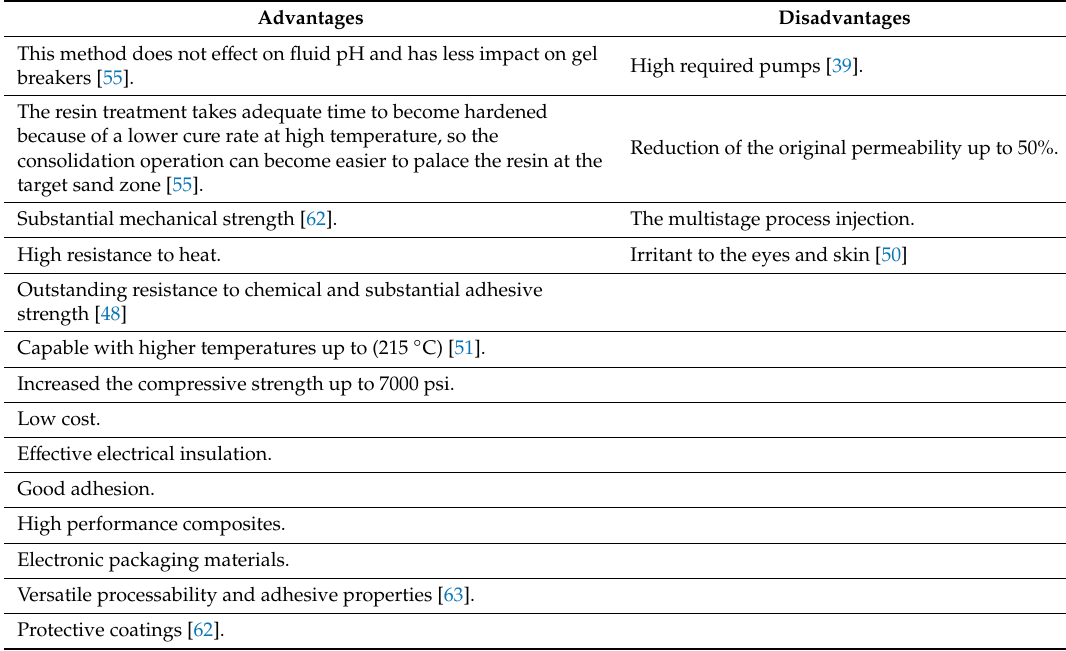
Table 6. Advantages and disadvantages of epoxy